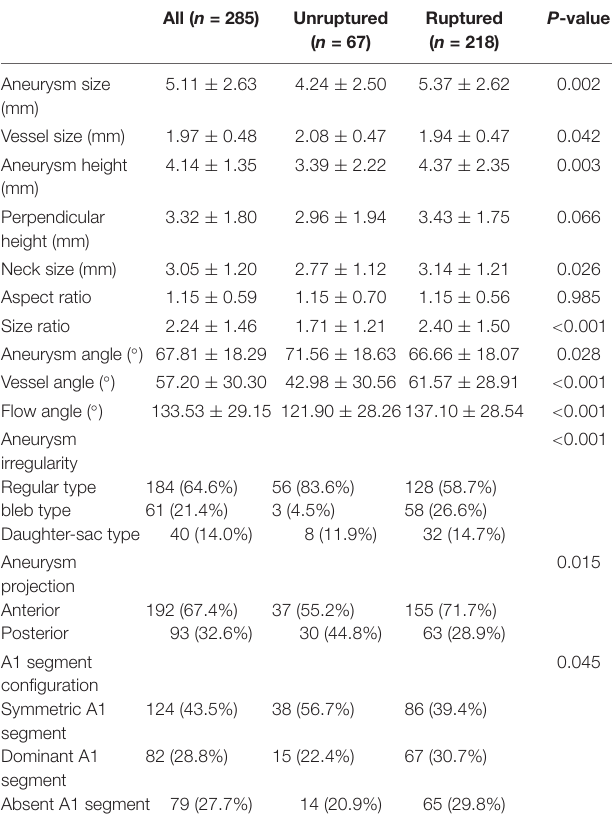
TABLE 2 | Morphological parameters between ruptured and unruptured